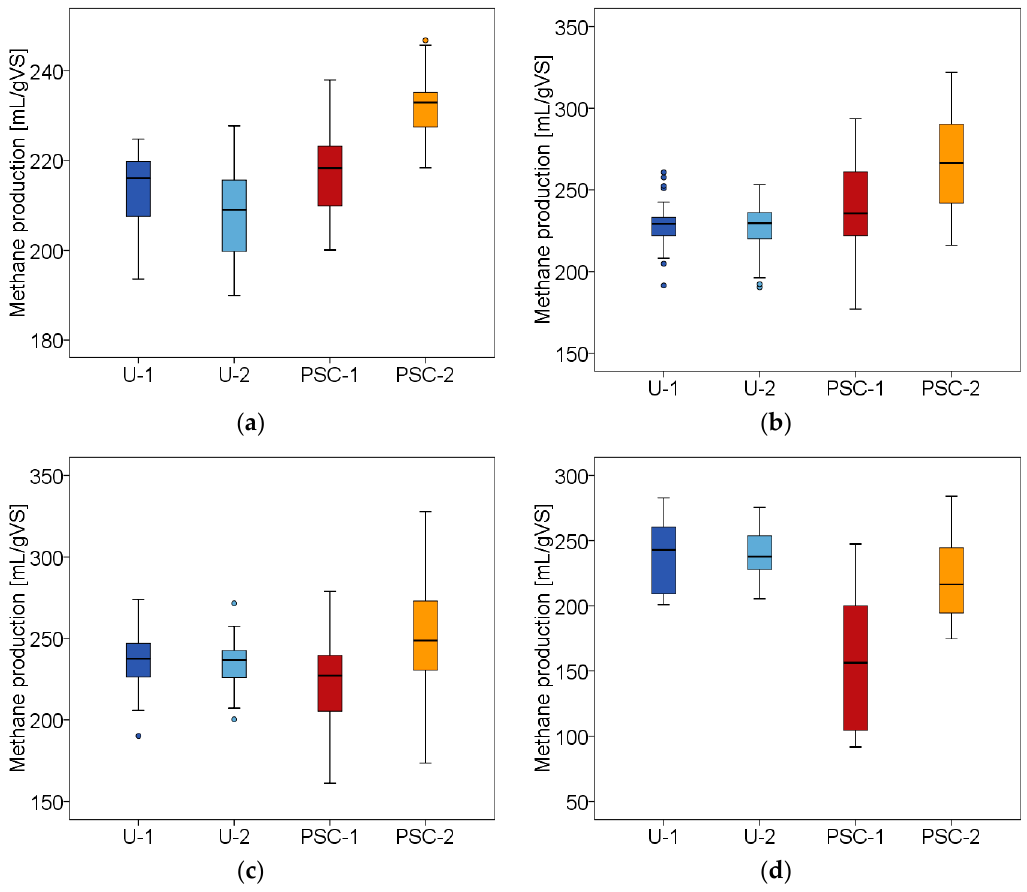
Figure 2. Boxplots of methane production ( a ) pre-phase; ( b ) hydraulic retention time (HRT) 1; ( c ) HRT 2; ( d ) HRT 3.